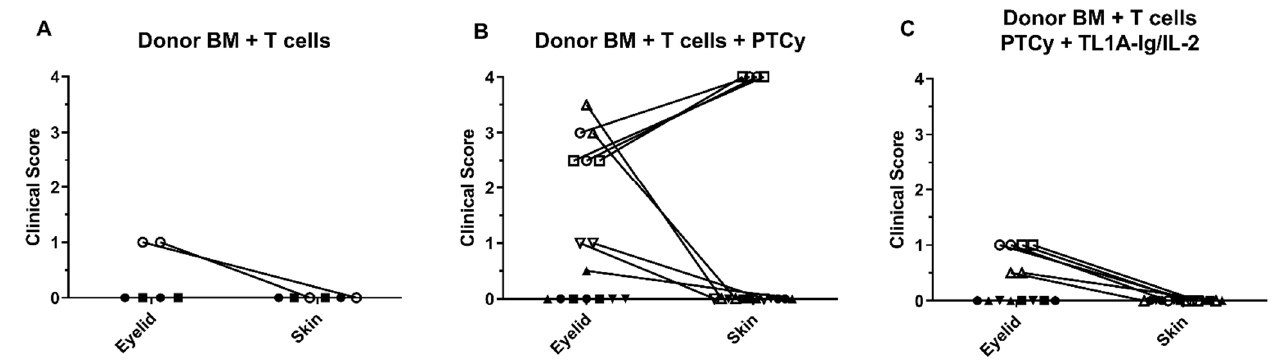
Figure 6. Analyses of ocular and skin GVHD in untreated and recipients treated early following HSCT in MHC-mismatched recipients. Transplants were performed with donor B6 TCD-BM + T cells into 8.5 gy conditioned BALB/c recipients. ( A ) Two levels of severity in animals were identified in mice surviving 6 weeks: one exhibiting low eyelid involvement and virtually no skin involvement and the other no eyelid or skin involvement. ( B ) Mice transplanted as described were treated on days 3 and 4 post-transplants with cyclophosphamide (“PTCy”, 50 mgs/kg). The levels of severity identified in ( A ) were again observed. A third level group exhibited significant eyelid and skin involvement. ( C ) Mice were transplanted and treated with PTCy as described in ( B ) and received treatment initiated at day 5 with anti-TNFRSF25 and anti-CD25 agonists to stimulate the Treg com- partment. (See Methods Section). Again, the same levels of severity as identified in panel A were identified in mice 6 weeks post-transplant, one exhibiting low eyelid involvement and virtually no skin involvement and the other no eyelid or skin involvement. The cumulative ocular eyelid score was determined by adding the scores (see Figure 1) of each eye from a single mouse. Each line rep- resents the eye and skin score of the same individual animal. Lines of points on the x-axis cannot be visualized. The open and closed symbols represent animals with a cumulative eyelid score of ≥ 1 and <1, respectively.